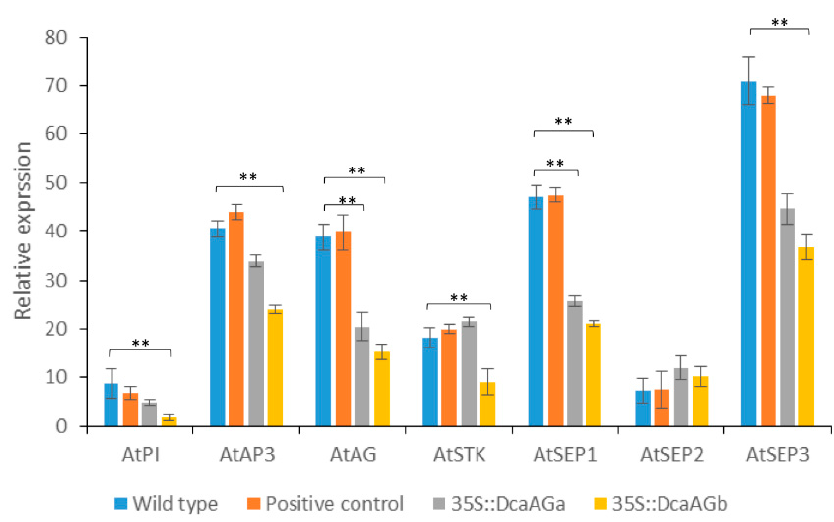
Figure 8. Quantitative PCR analysis of AtPI , AtAP3 , AtAG , AtSTK , AtSEP1 , AtSEP2 , and AtSEP3 in wild type, positive control group, 35::DcaAGa and 35::DcaAGb transgenic Arabidopsis . The expression of AtPI , AtAP3 , AtAG , AtSTK , AtSEP1 , and AtSEP3 in transgenic Arabidopsis show a significant difference, compared to the wild type and positive control group plant. ** indicates p < 0.01 by student’s t -test. Positive control represents the plants are transformed with pCAMBIA2300s vector.